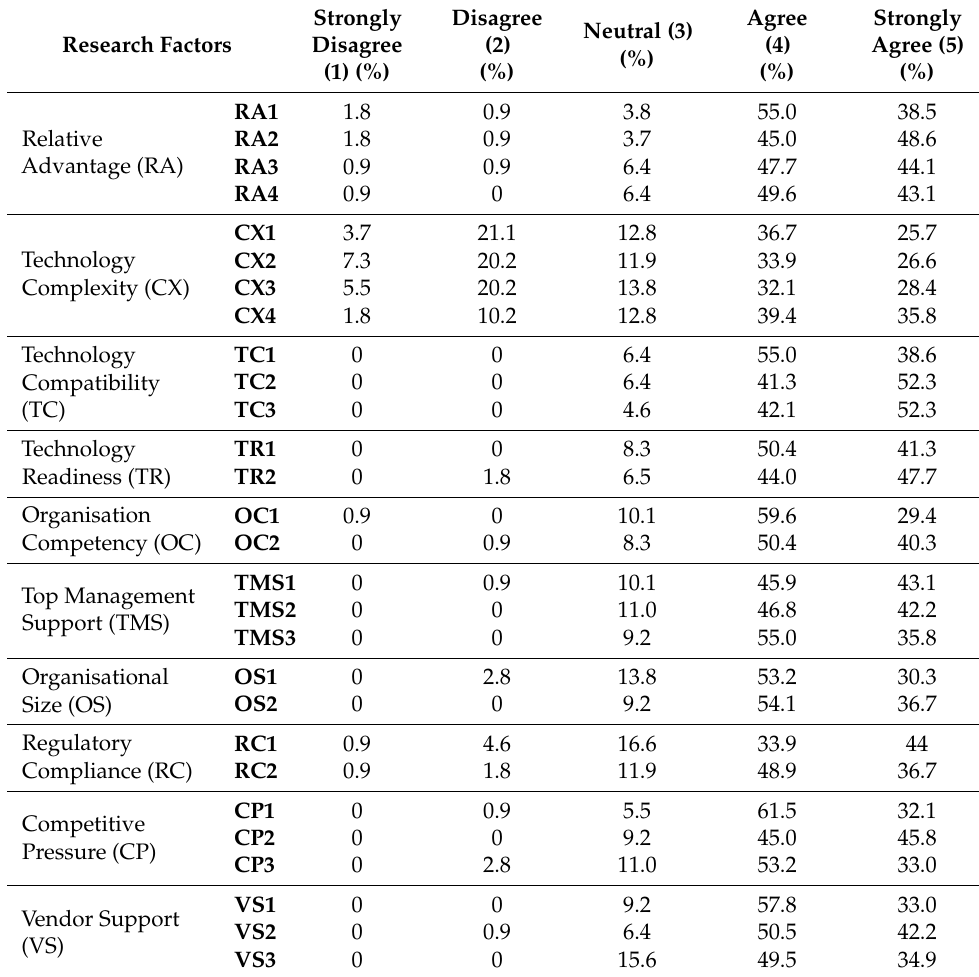
Table 8. Analysis of the effect of research factors considered for the